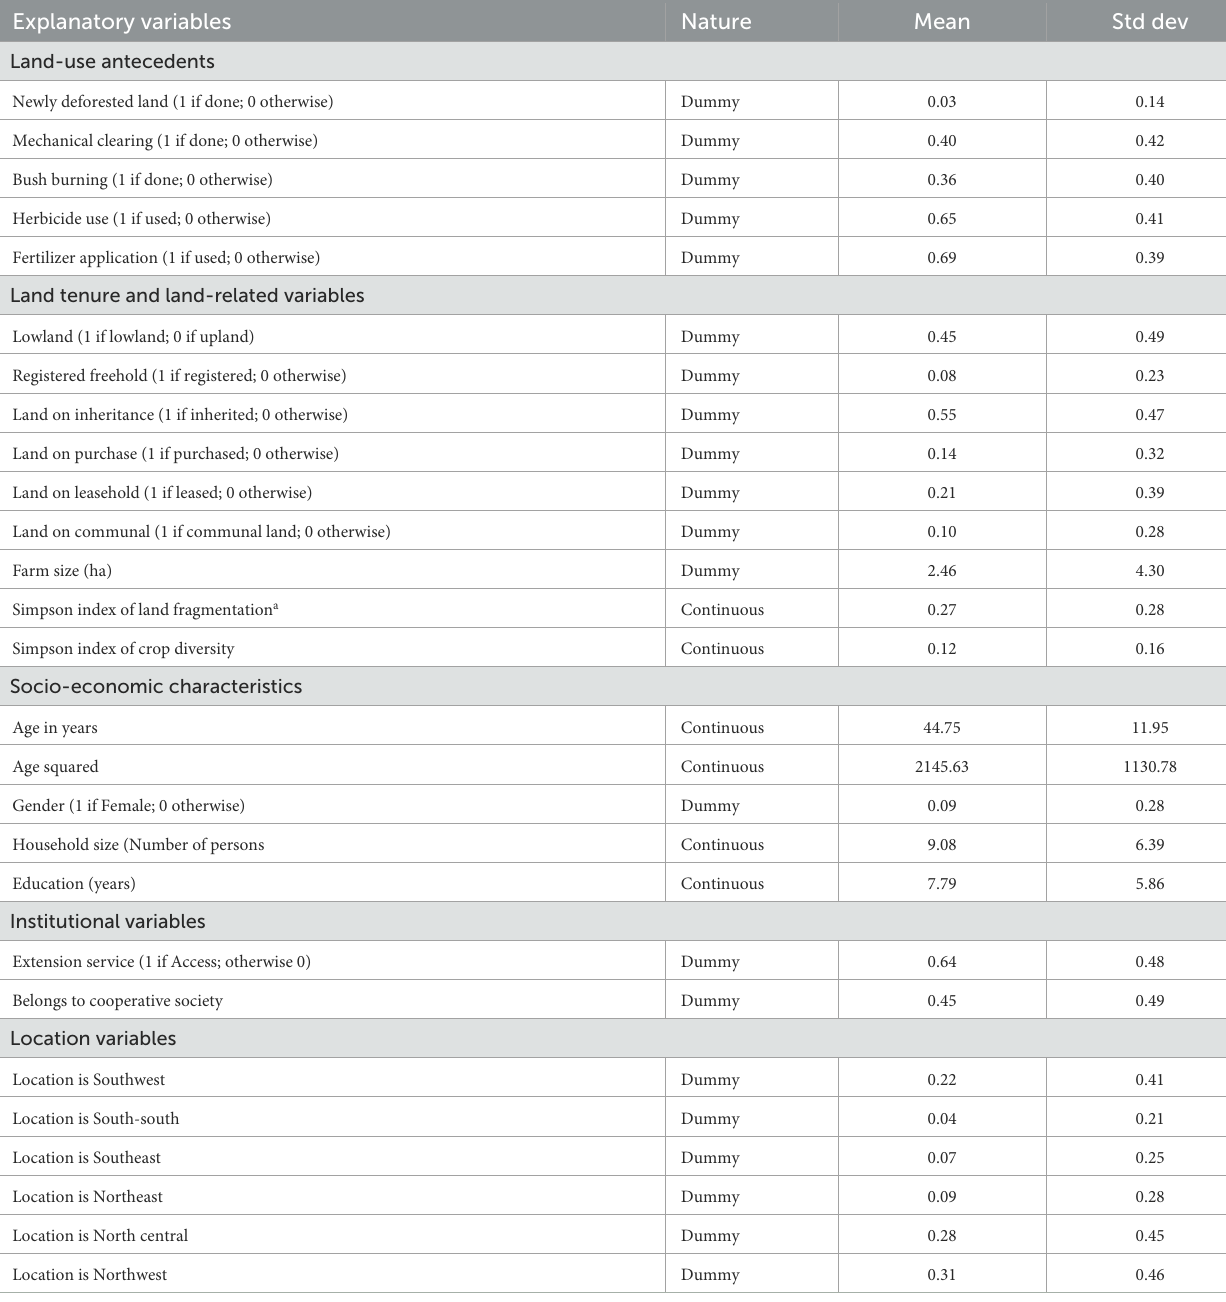
TABLE 1 Definitions of study variables and their descriptive statistics. Explanatory